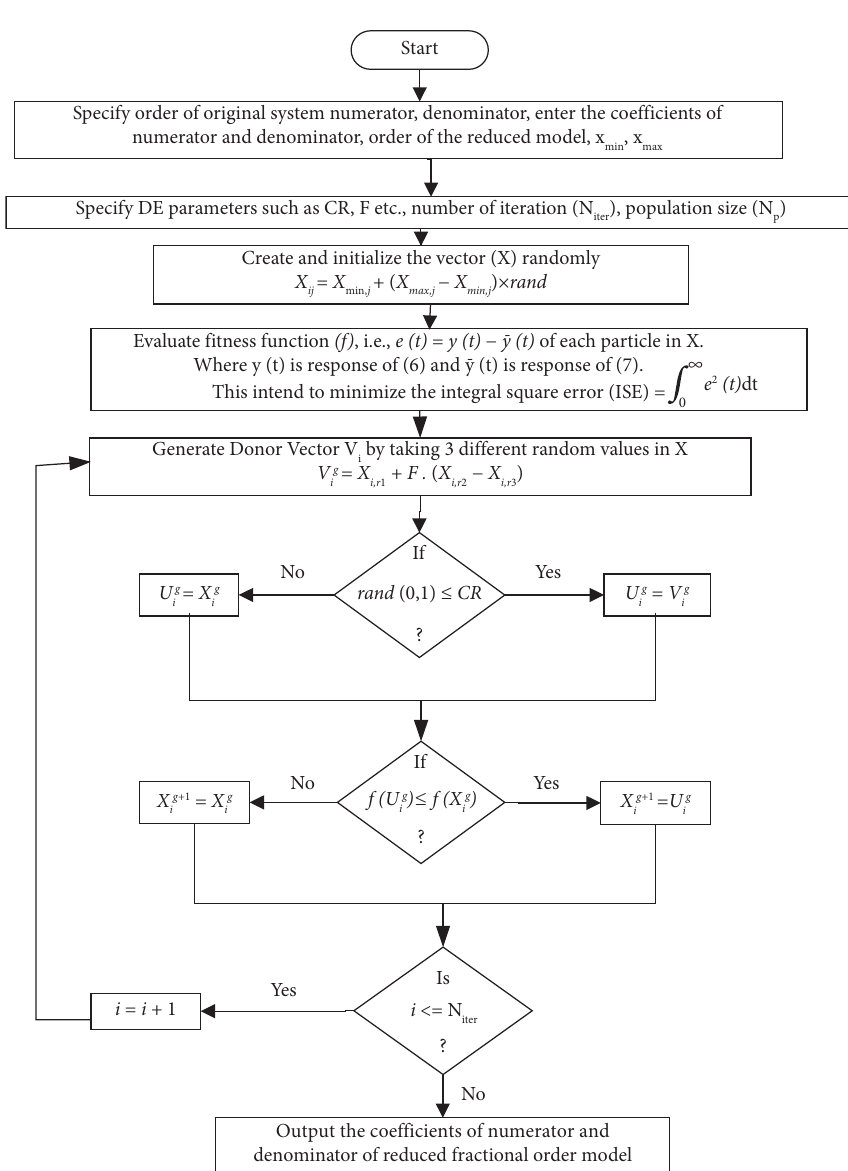
Figure 1: Application of diferential evolution (DE) method to reduce fractional-order model from original